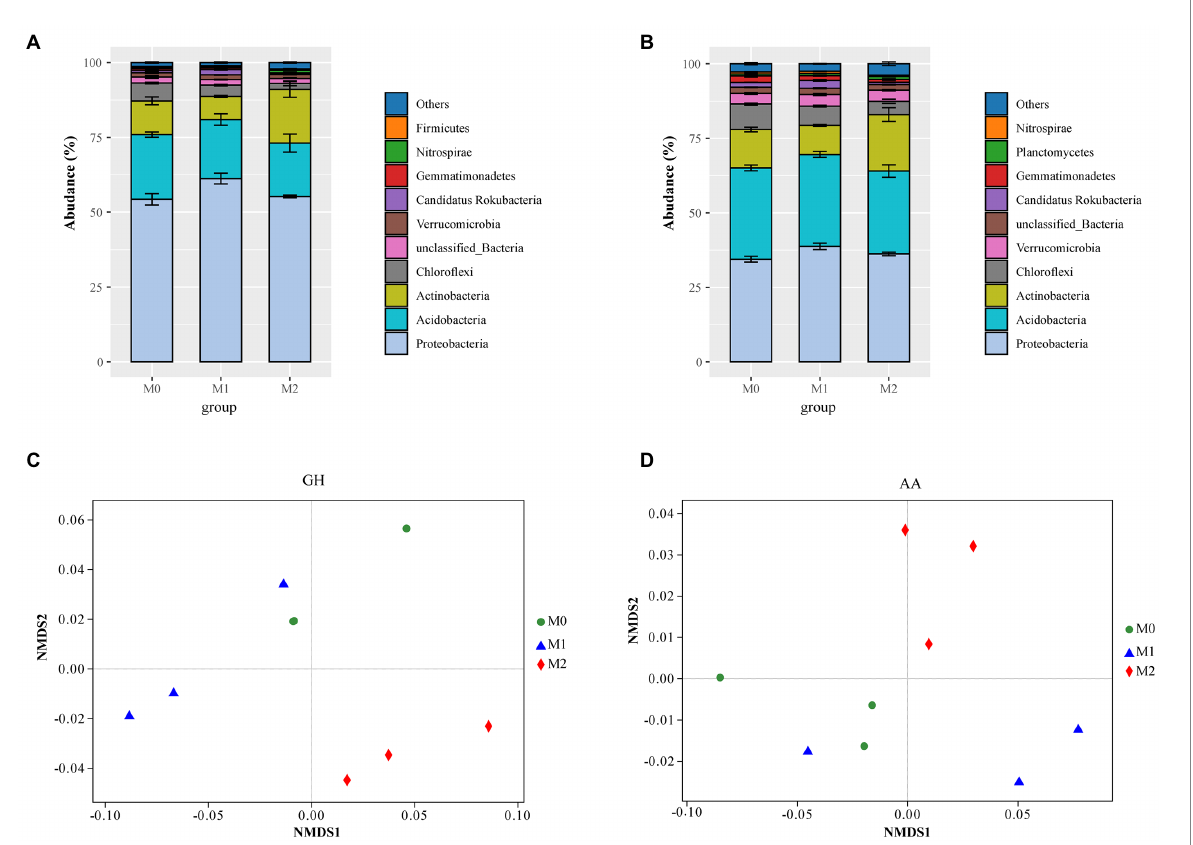
FIGURE 1 The abundance of microbial glycoside hydrolases (GHs) and auxiliary activities (AAs) in the bamboo plantations under different management practices. (A,B) contribution of microbial phyla to the GHs and AAs families; (C,D) Non-metric multidimensional scaling (NMDS) of the GH and AA families. M0, M1, and M2 indicates undisturbed, extensively managed, and intensively managed bamboo plantations,